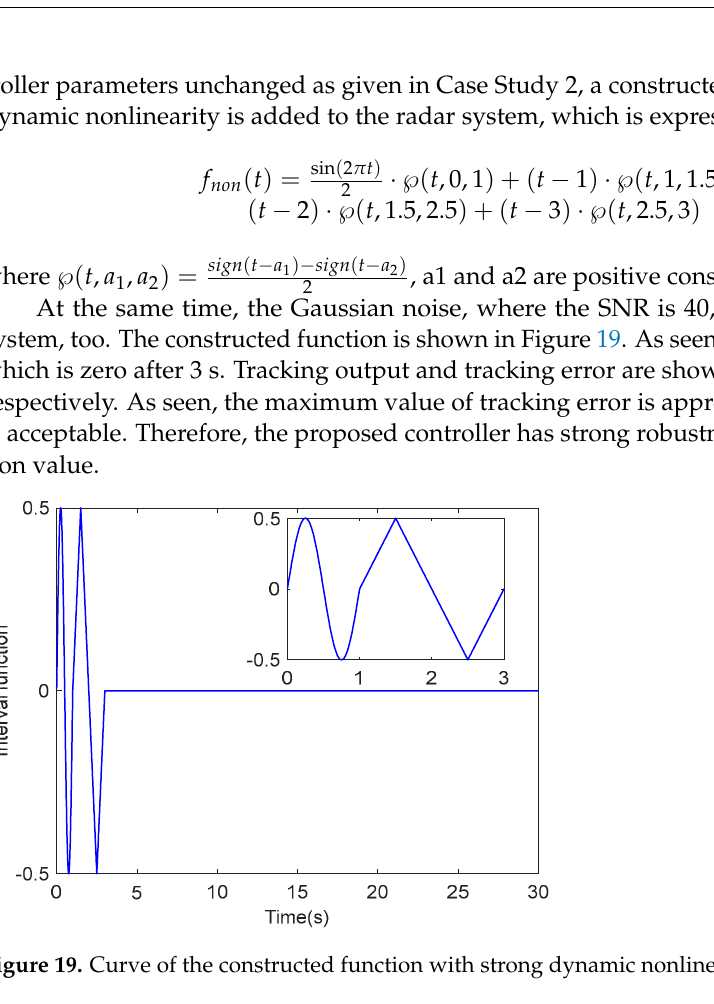
Figure 21. Tracking error of the DRNN-LADRC for the new radar servo system. 4.5. Case Study 5: Step Response Via the LADRC by Introducing ATD